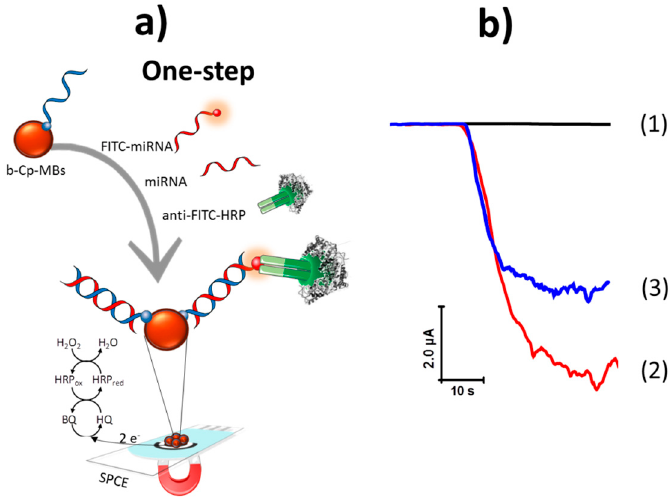
Figure 1. ( a ) Schematic display of the amperometric biosensor developed for miRNA-21 determination based on a competitive DNA/RNA hybridization assay onto magnetic beads (MBs) and amperometric detection using the H 2 O 2 / Hydroquinone (HQ) system at a screen-printed carbon electrode (SPCE). ( b ) Amperometric responses obtained with the developed biosensor in the absence (1) and in the presence of 2.5 nM FITC-miRNA (2) and 5.0 nM of miRNA-21 (3). HRP: horseradish peroxidase, BQ: 1,4-hydroquinone.